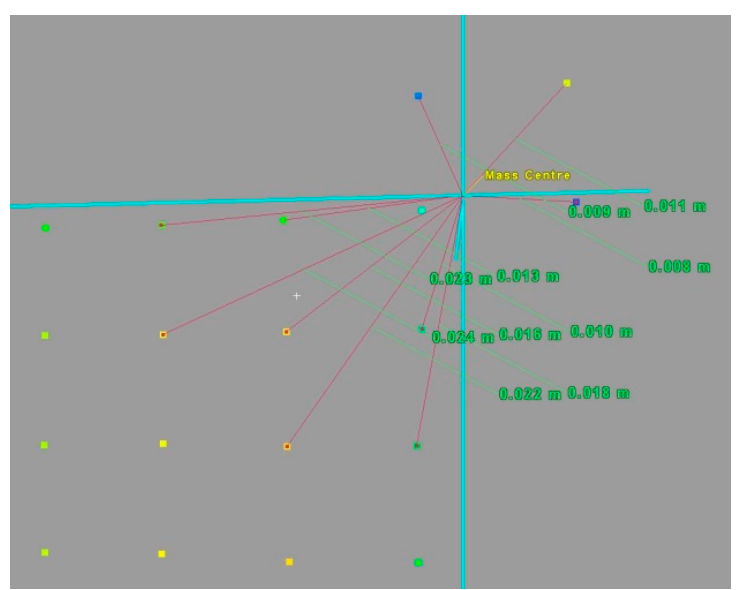
Figure 10. Example of the nearest neighbour analysis for inner extreme points.